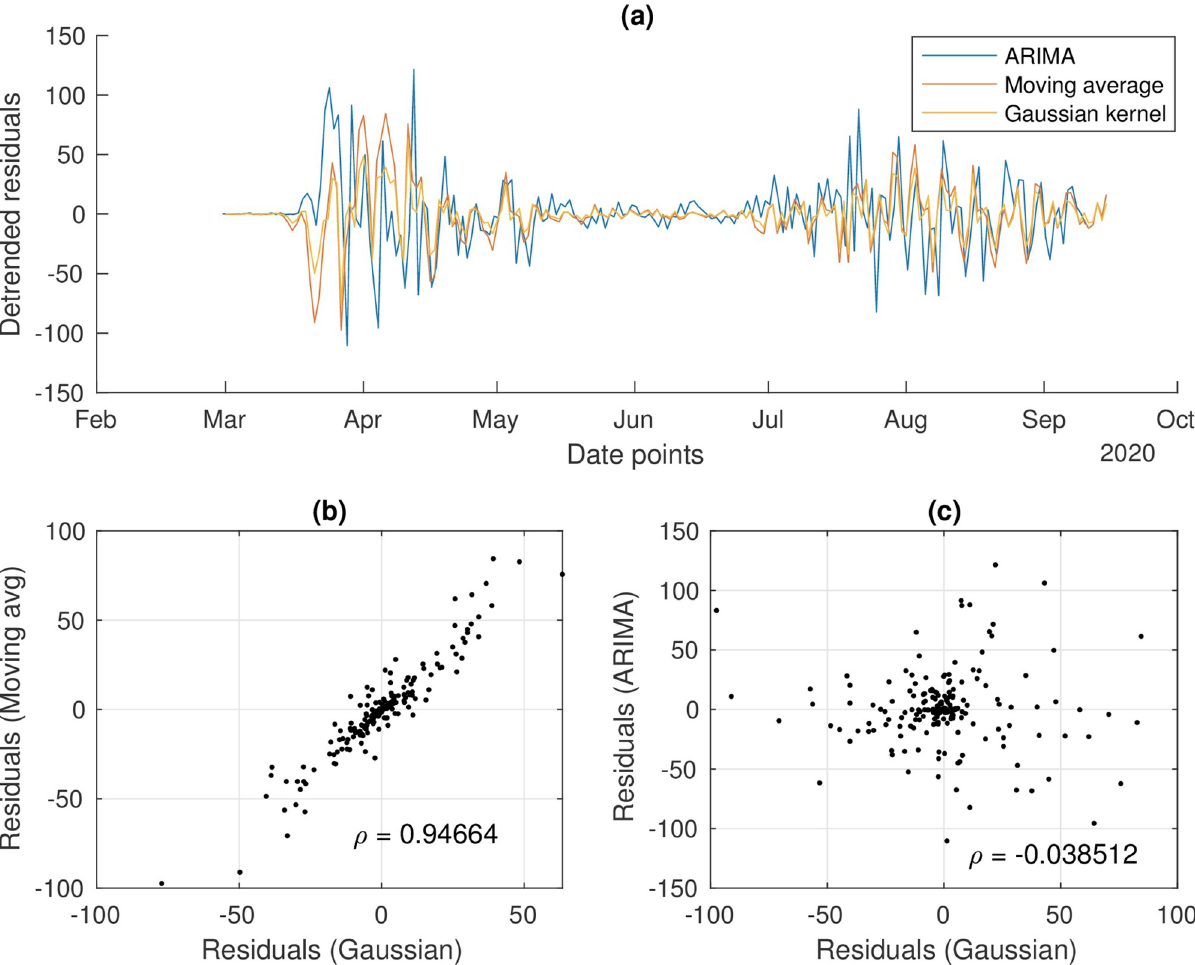
Fig 2. Analysis of the residuals from the detrending methods (case study from Luxembourg shown). a) The detrended fluctuations time series. b) Correlation between residuals obtained from Gaussian or moving average filtering. c) Correlation between residuals obtained from Gaussian or ARIMA